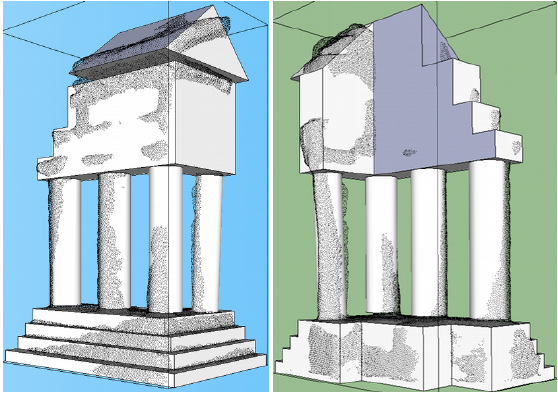
Figure 3. Reconstructed bare-bones model from the temple 3D point clouds. The original points are also shown in the figure.